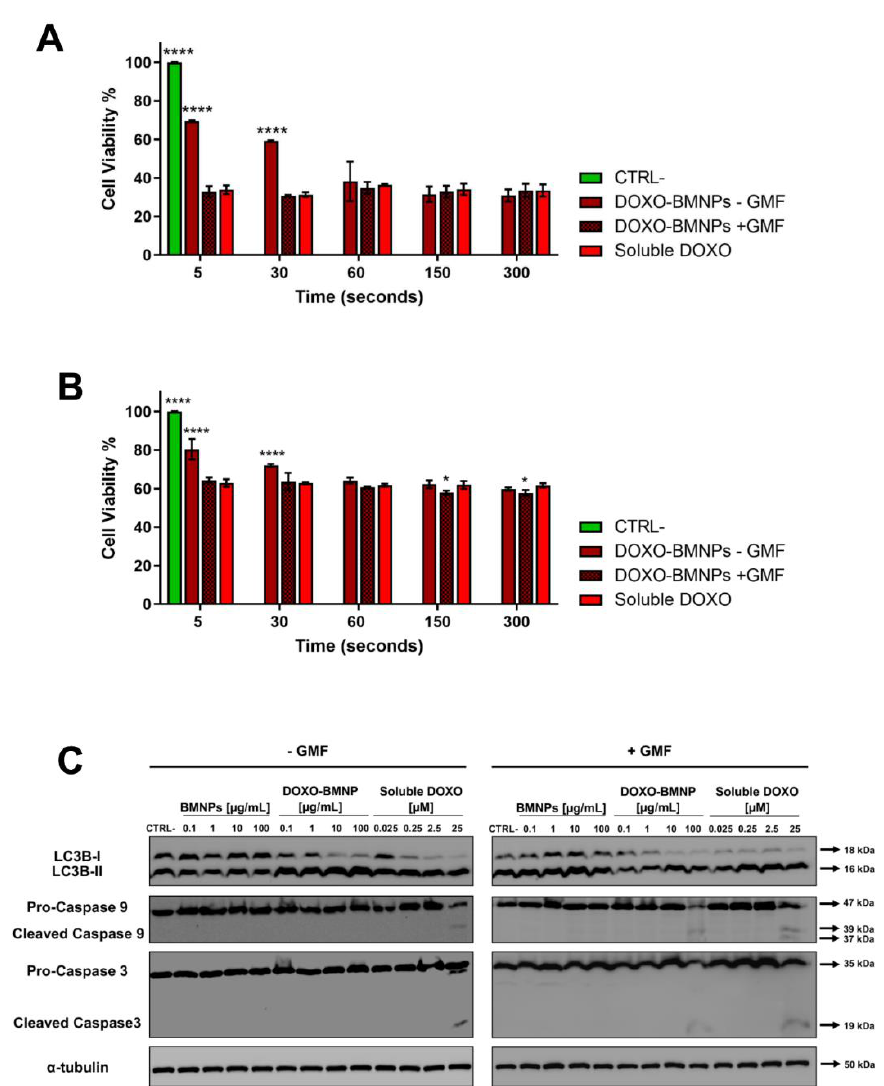
Figure 5. 4T1 ( A ) and MCF-7 ( B ) cells were incubated with drug-loaded BMNPs and treated with a GMF for di ff erent times, after which BMNPs and media were withdrawn and cells were replenished with fresh media and incubated for a further 72 h in an MTT assay. Soluble DOXO was used as a positive control. In all experiments, untreated cells receiving medium without nanoparticles were taken as the reference value (100%) of viable cells. Data are the average of 3 independent experiments performed in triplicates. Di ff erences between groups were assessed by 2-way ANOVA with Dunnett’s multiple comparison test (**** p < 0.0001). ( C ) Expression and state of activation of LC3b-I, caspase 3, and caspase 9. Extracts from 4T1 cells incubated for 16 h with di ff erent concentrations of BMNP ± DOXO in the absence / presence of a GMF were analyzed in Western blot. All blots shown are representative of three independent experiments. A Western blot representative of the bands of tubulin is shown, since in all experiments, similar patterns were observed.